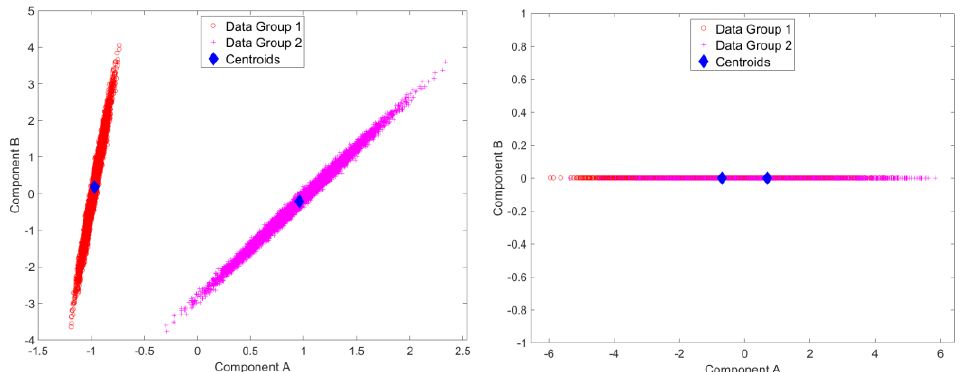
Figure 6. Results of standardized component scores for the test set of 10,000 different trajectories per group in the test set for the Blink dataset: ( left ) single-level PCA; ( right ) level 1, mPCA. These results again show strong clustering with respect to the two groups (i.e., “surprised” in group 1 and “blinking” in group 2.).